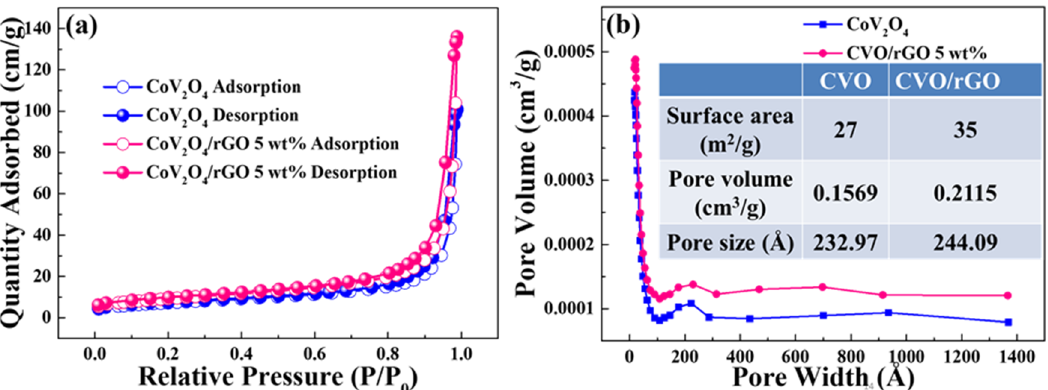
Figure 4. ( a ) Nitrogen adsorption isotherms and ( b ) the BJH desorption pore volume distributions of bare CoV 2 O 4 and rGO-wrapped CoV 2 O 4 materials; inset: the table shows the estimated values.